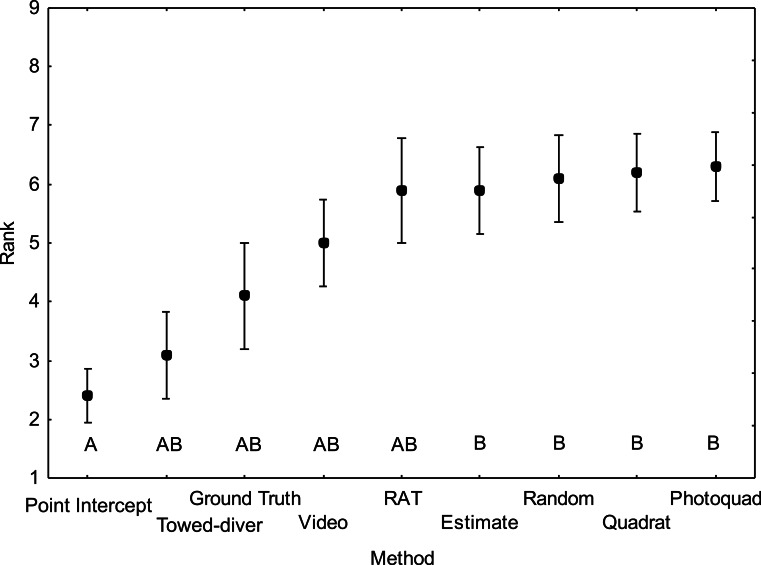
Average ranking of coral cover at each site for the nine benthic survey methods (N = 10) plotted from Table 5 data.Mean number ± 1 SE. Methods in each group are statistically different than those in other groups while group AB has means statistically similar to those in both groups A and B (Tukey HSD post-hoc test on raw data (F8,81 = 4.0 p < 0.001).